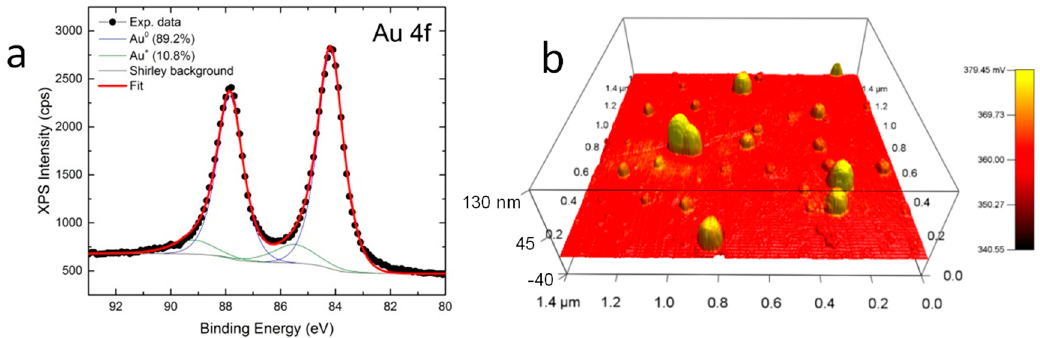
Figure 2. ( a ) XPS measurement of the Au NPs drop-cast onto HOPG, showing the presence of oxidized Au together with metallic Au; ( b ) AFM 3D image of topographic profile of the NPs on silicon, with electrical surface potential overlaid as the color